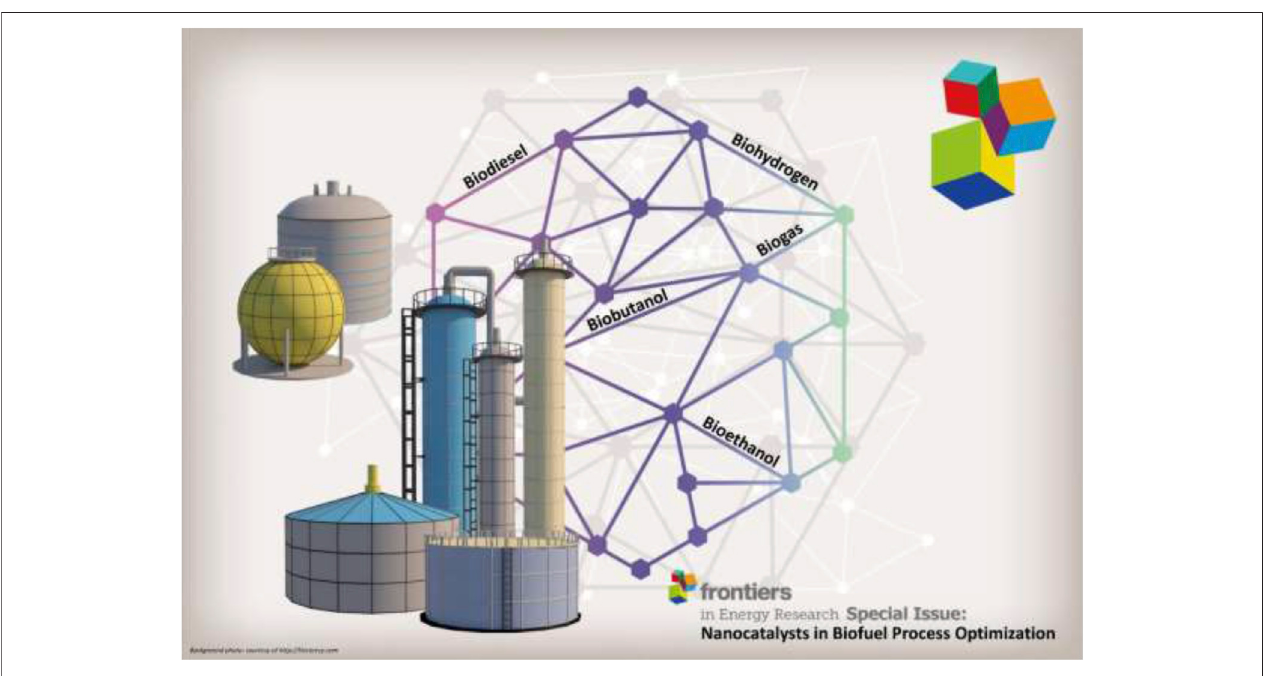
FIGURE 1 | Nanocatalysts in biofuel process optimization